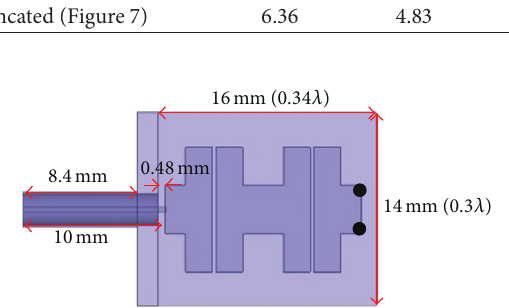
Figure 7: Truncated version of the SC SE-EBG-RA in Figure 1(b) including the SMA and the connectors; unit cell dimensions are as in Figure 1(c).